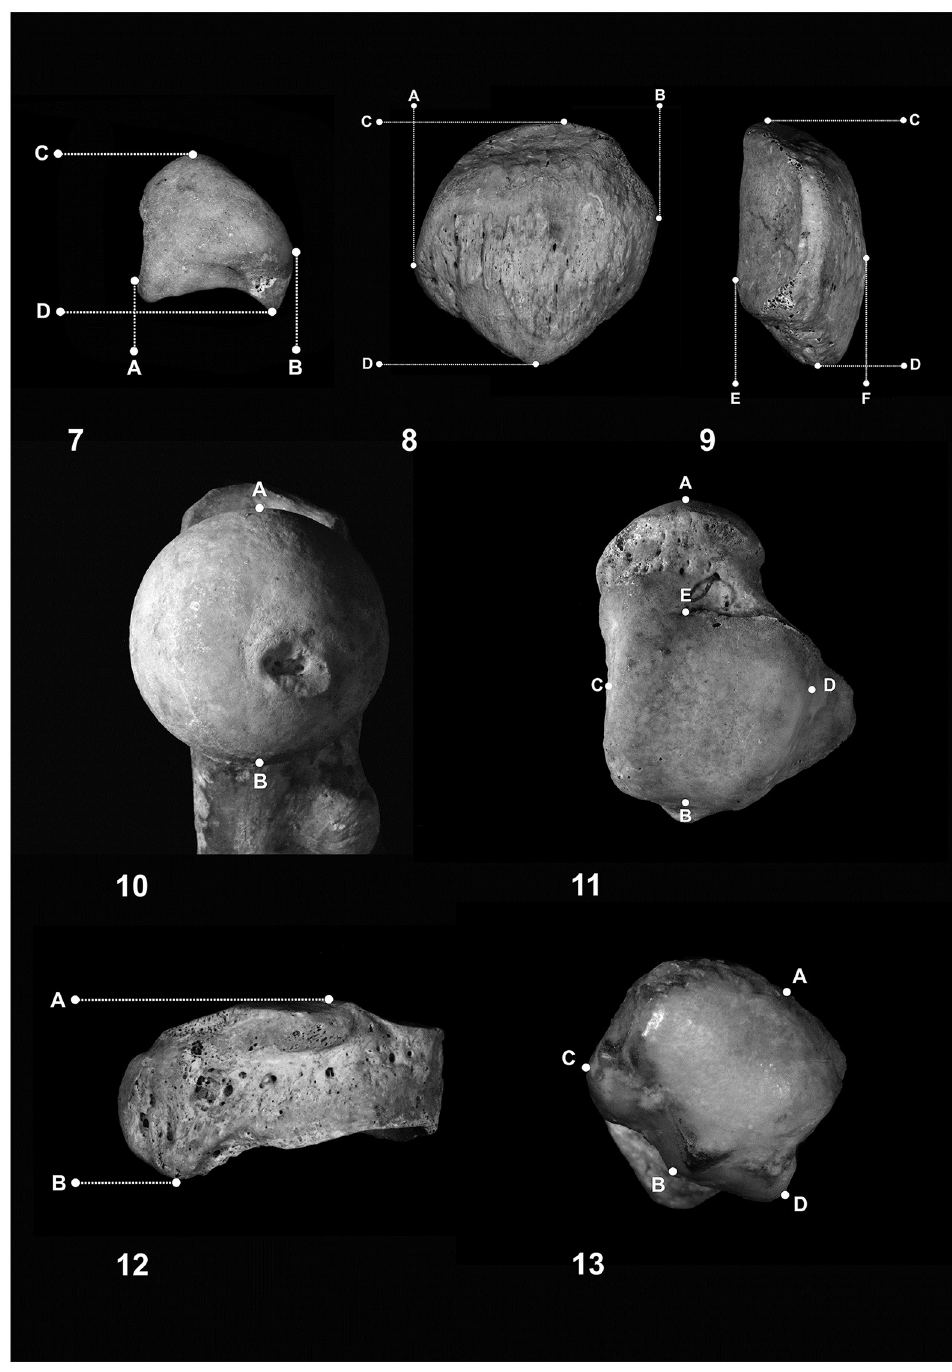
Fig 4. Schematic illustration of 13 measurements used in the study. 7) Lunate: A-B = maximum width; C-D = maximum length; 8 & 9) Patella: A-B = maximum width; C-D = maximum height; E-F maximum thickness; 10) Femural head: A-B = vertical diameter; 11) Talus: A-B = maximum length; A-E = head-neck length; C-D = trochlea width; E-B = trochlea length; 12) Navicular: A-B = maximum length; 13) First metatarsal head: A-B = dorso-plantar width; C-D = medio-lateral